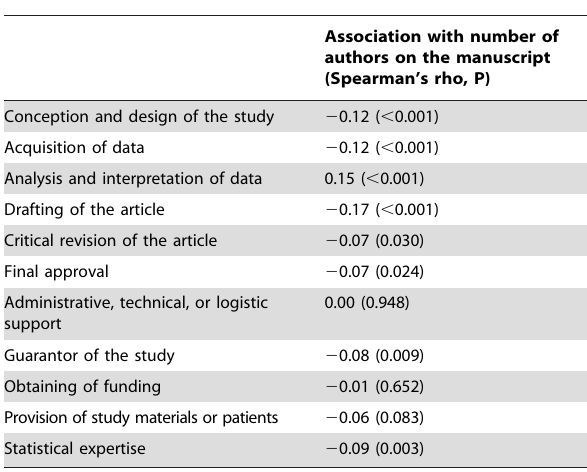
Table 2. Associations between authors’ ratings